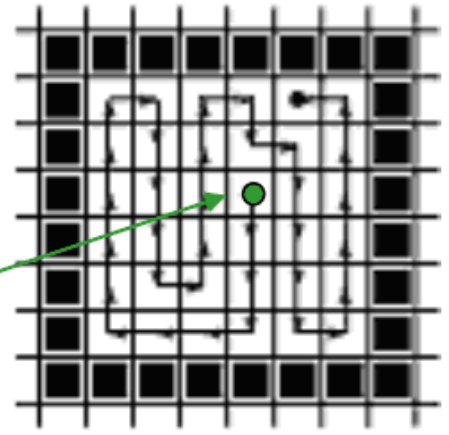
Figure 11. Area bypass example.